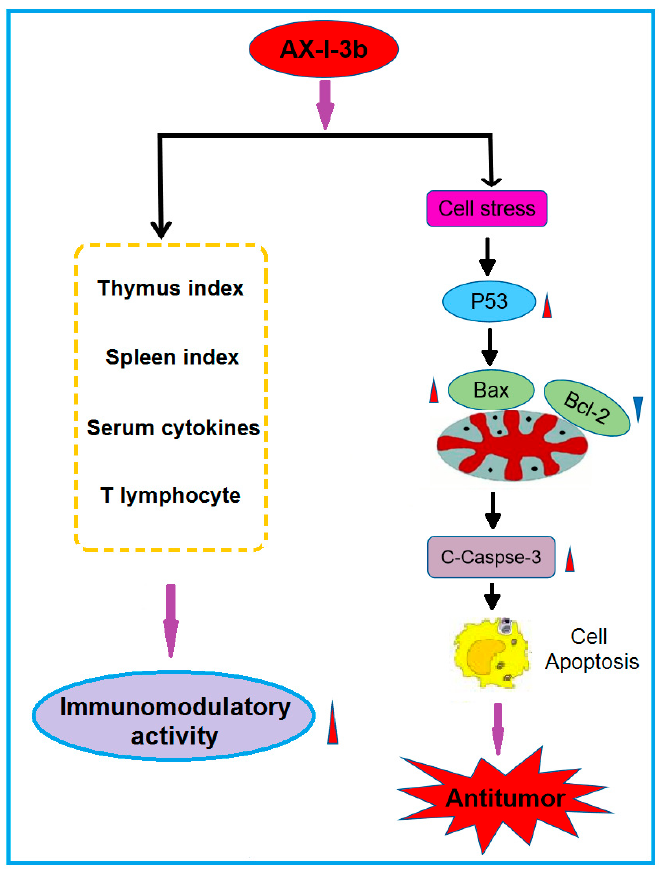
Figure 11. Immunomodulatory activity and potential anti-tumor mechanism of AX-I-3b.